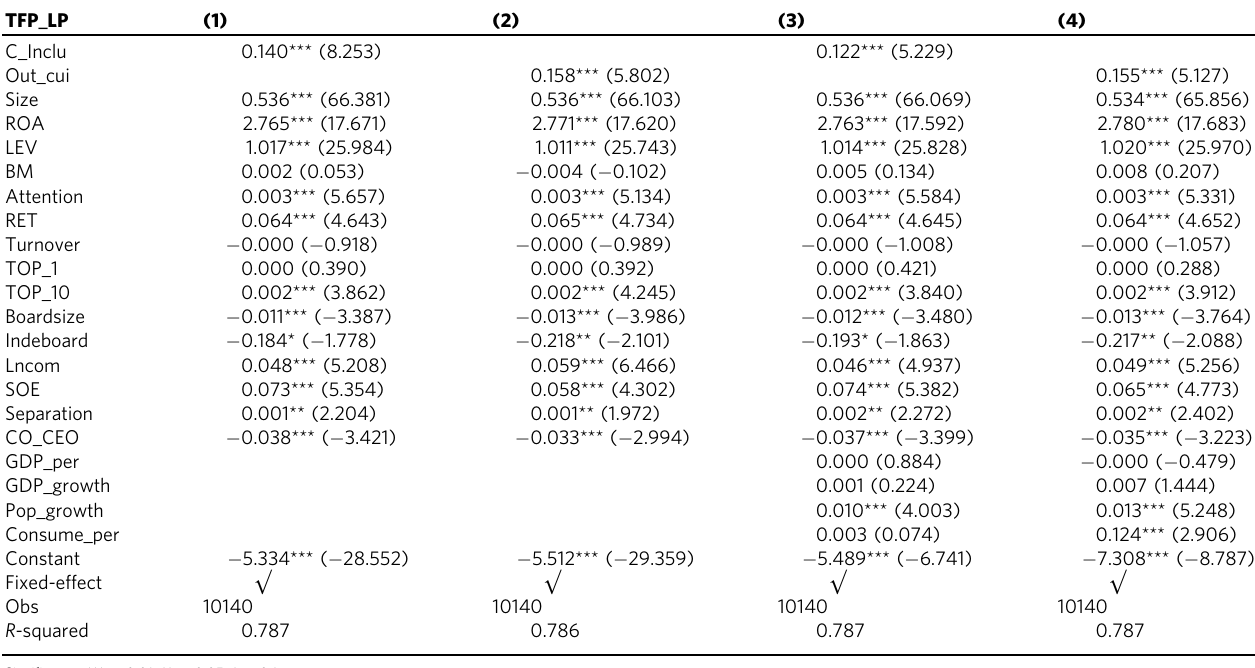
Table 3 The impact of cultural inclusion on corporate